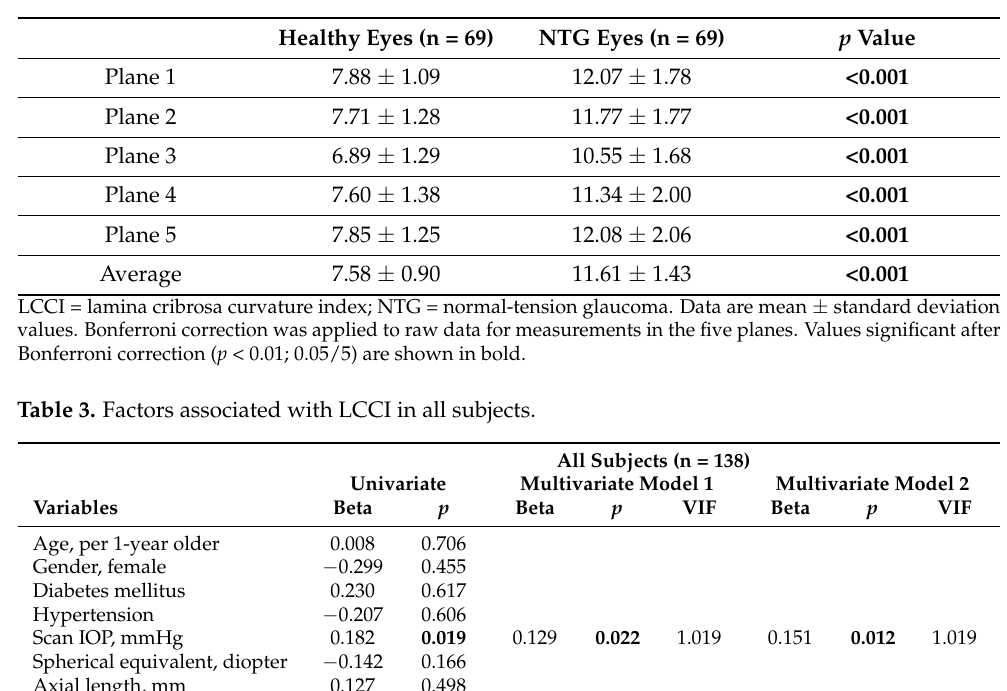
Table 2. Comparison of LCCI in healthy and NTG eyes.